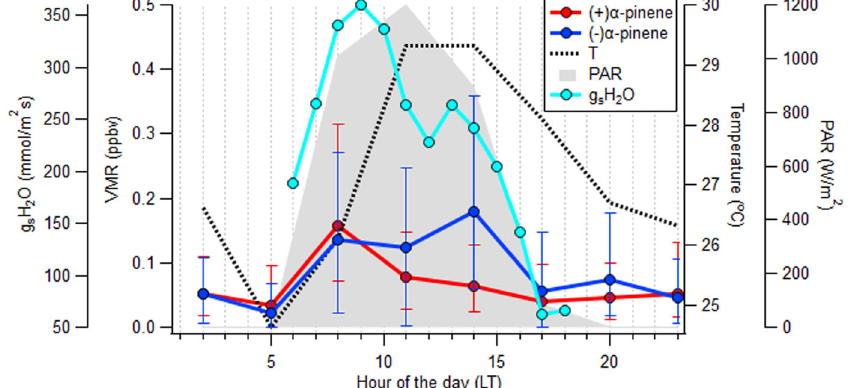
Fig. 7 Median values of ( − )- α -pinene and ( + )- α -pinene volume mixing ratios measured during the dry season campaign at 80 m. Incoming photosynthetic active radiation (PAR) and air temperature were measured at 80 m at the neighboring instant tower at the same time, stomatal conductance was measured on 6/11/2017 for four trees at 20 m and 32 m adjacent to the INSTANT tower. Error bars indicate 25 and 75 percentiles of the campaign